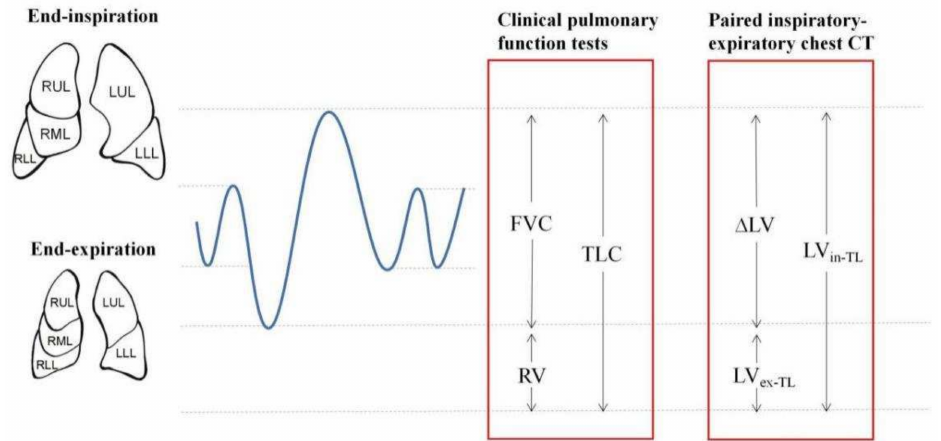
Figure 2. Schematic diagram of ventilatory function and paired inspiratory–expiratory chest CT indexes during breathing. The blue line represents the lung volumes and capacities on static breathing and full inspiration-expiration.